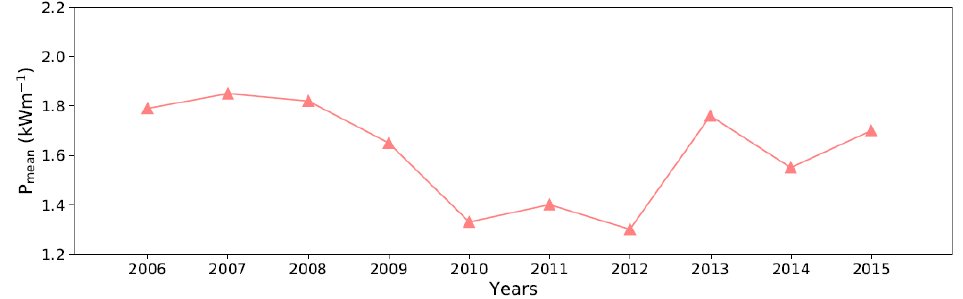
Figure 9. Time series of the yearly available wave power averaged along the line offshore from the harbour breakwater.